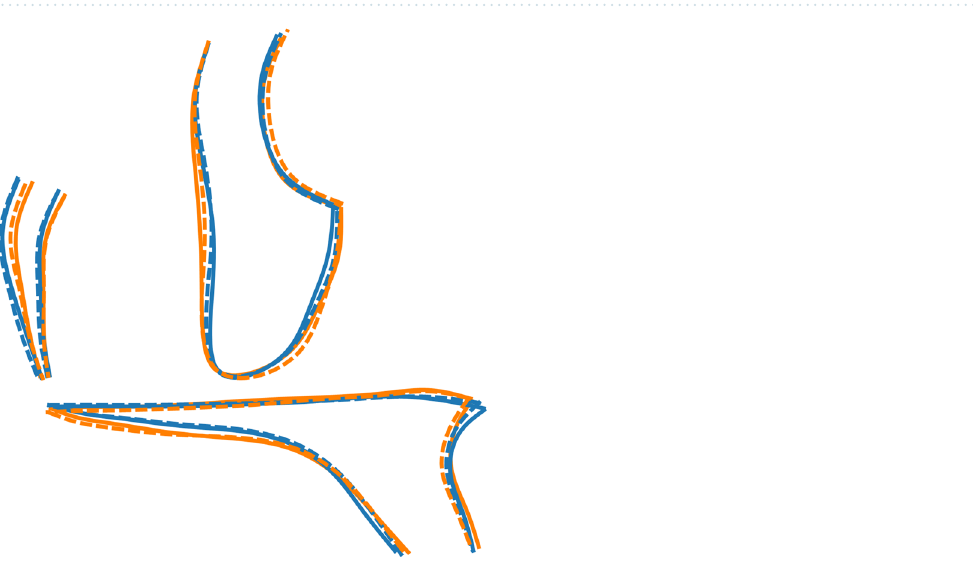
Figure 9. Procrustes superimposition of the average shapes of the maxilla. Orange: βTh group, blue: Ctrl group, solid line: males, dotted line: